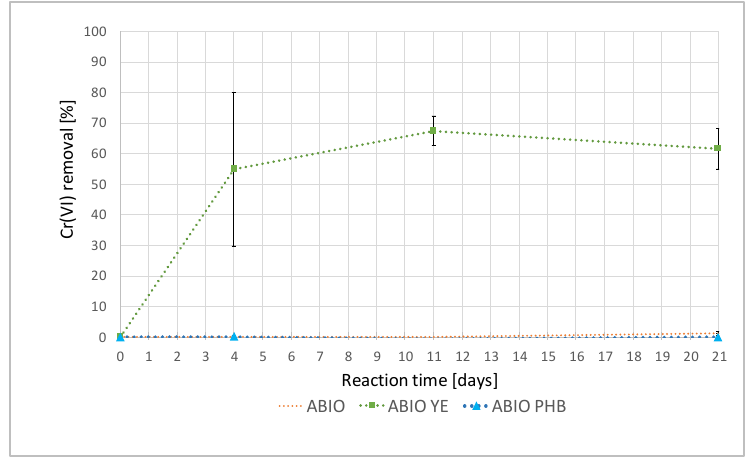
Figure 3. Percentage of Cr(VI) removal in the sterile reactors during the experiment.